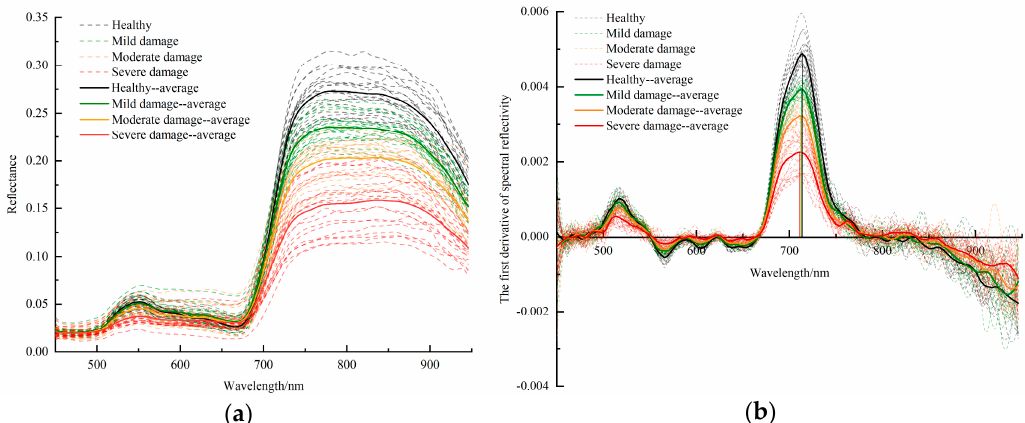
Figure 7. The curves of Yunnan pine canopies with different degrees of damage. ( a ) Spectral reflectance curves and ( b ) first derivative curves.